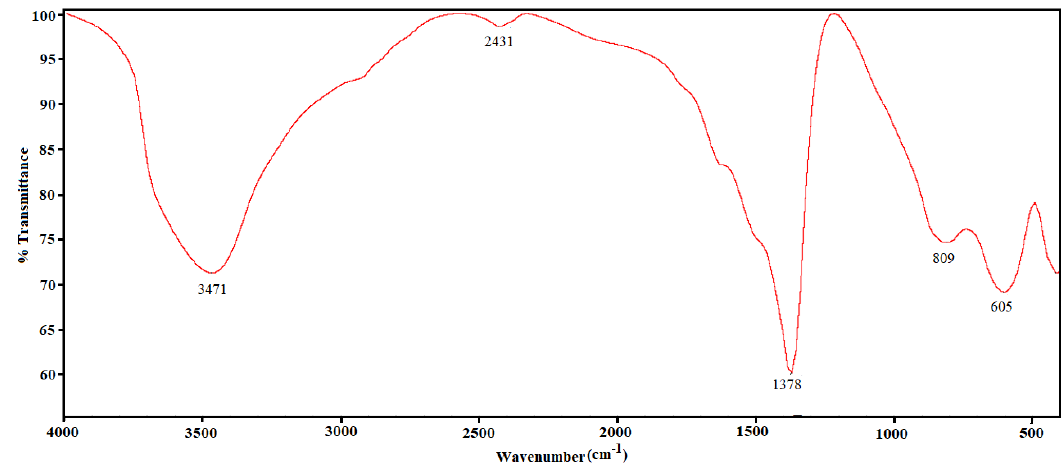
Fig.2. FTIR spectra of Mg-Al layered double